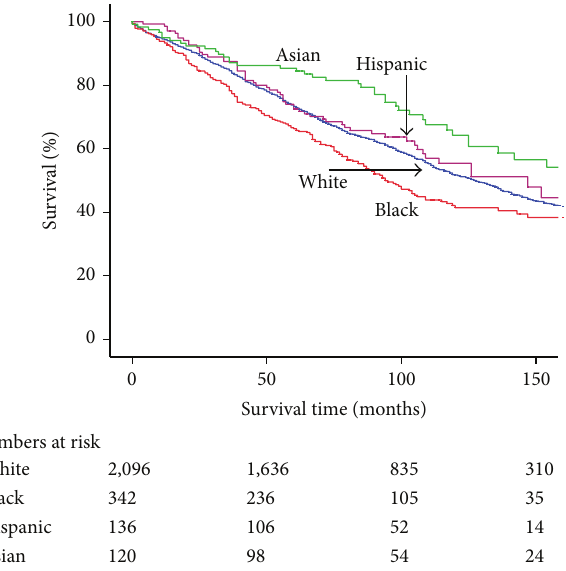
Figure 1: Kaplan-Meier overall survival by